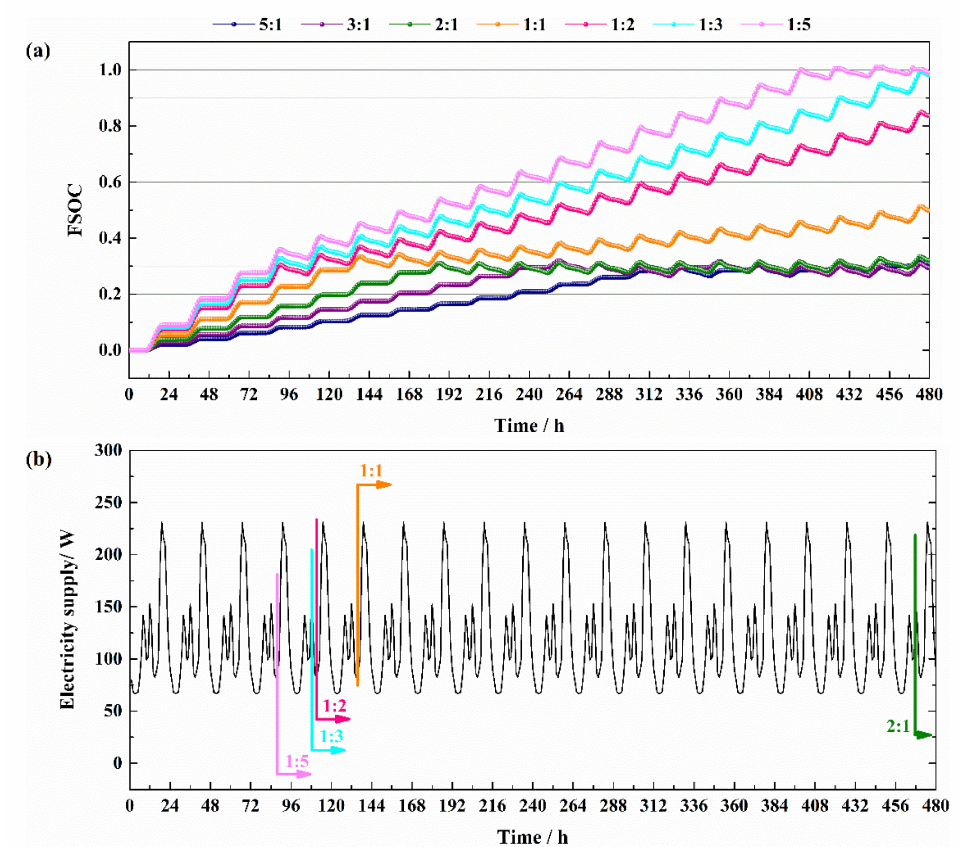
Figure 14. Hourly characteristics of the hybrid system in Andir: ( a ) FSOC of the first twenty days; ( b ) the start time of electricity supply continuity with different installed capacity ratios of WT and